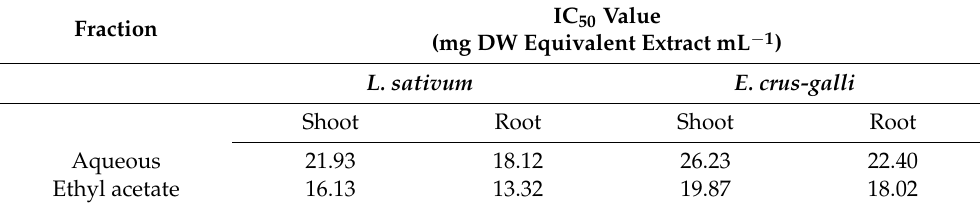
Figure 2. Growth inhibitory effect of the aqueous and ethyl acetate fractions separated from the S. garrettiana leaf extracts against the growth of ( A ) L. sativum seedlings and ( B ) E. crus-galli seedlings. Values are the mean (±S.D.) of three replicates (n = 30); different letters on each bar indicate a statistically significant difference between treatments (Tukey’s HSD, at the 0.05 probability level). Table 2. The concentration required for 50% growth inhibition (IC 50 ) of the shoot and root growth of test plant species by the aqueous and ethyl acetate fractions separated from S. garrettiana leaf extracts.